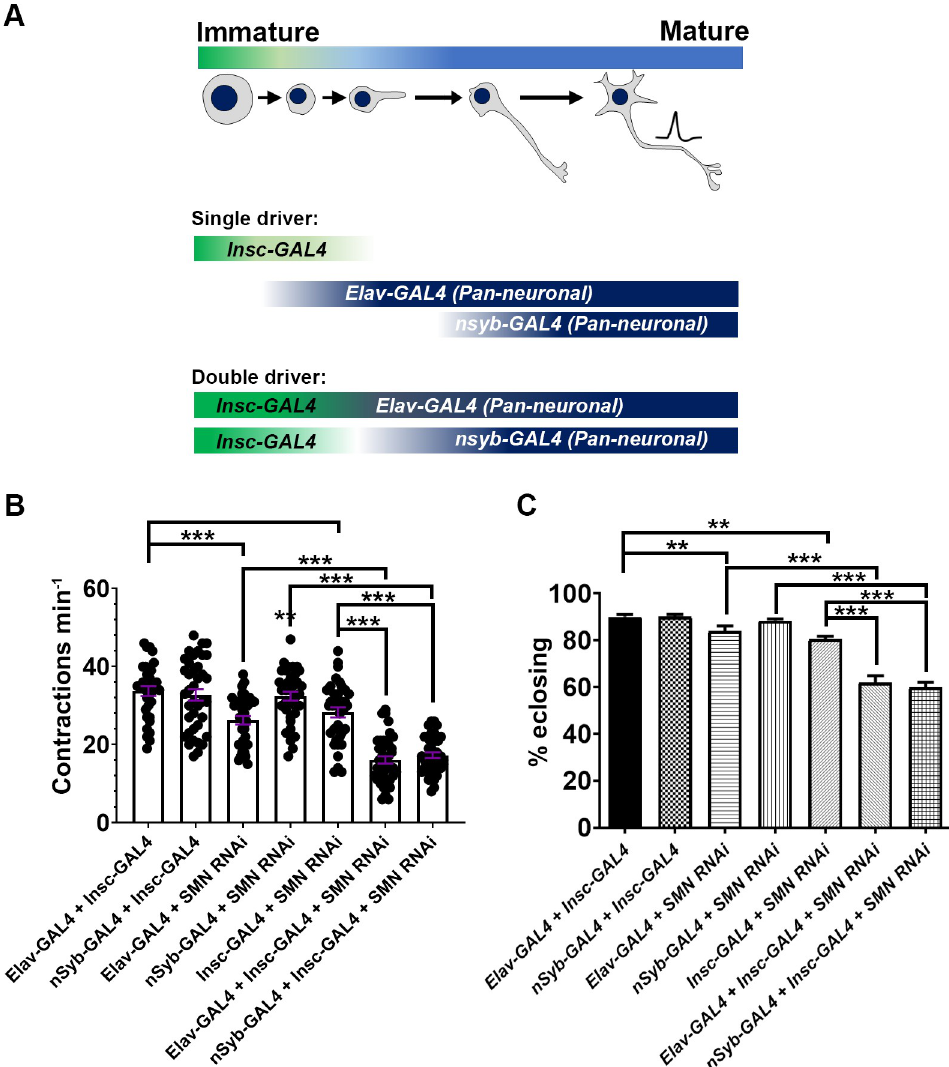
Fig 6. Dual knockdown of survival motor neuron (SMN) in neuroblasts and differentiated neurons synergistically enhances the SMA model phenotypes. (A) GAL4 nervous system expression patterns detailing the driver type and single and double-driver combinations used to knock down Smn . For negative controls Elav-GAL4 + Insc-GAL4 and nSyb-GAL4 + Insc-GAL4 were used. Elav-GAL4 , Pros-GAL4 and Insc-GAL4 driven UAS-SMN-RNAi N4 were used as positive controls and compared with Elav-GAL4 + Insc-GAL4 and nSyb-GAL4 + Insc-GAL4 driven UAS-SMN-RNAi N4 ; (B) the genotypes were assessed for locomotor dysfunction at 72 h after hatching. Elav-GAL4 + Insc-GAL4 and nSyb- GAL4 + Insc-GAL4 driven UAS-SMN-RNAi N4 underwent reduced peristaltic contractions compared with negative and positive controls ( ��� P < 0.001, n > 20, Kruskal–Wallis test with Dunn’s multiple comparisons); (C) fly hatching number was then assessed to analyse survival to adulthood. Elav-GAL4 + Insc-GAL4 and nSyb-GAL4 + Insc-GAL4 driven UAS-SMN-RNAi N4 survived compared with negative and positive controls ( ��� P < 0.001; three experiments, each with n > 50; Kruskal–Wallis test with Dunn’s multiple comparisons). All error bars